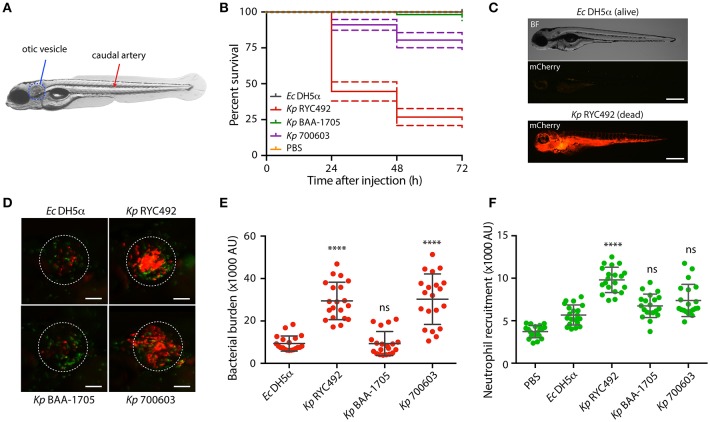
K. pneumoniae strains show different virulence behavior in the zebrafish larvae as revealed by survival curves and neutrophil recruitment. (A) Scheme of a 5-dpf zebrafish larva. Bacteria were injected in the dorsal caudal artery (red arrow) for establishing a rapid systemic infection, or in the otic vesicle (blue circle) for a localized infection. (B) Kaplan-Meier survival curves following injection of 3 dpf larvae with various strains of K. pneumoniae or with E. coli DH5α as a control. Larvae survival was monitored for 3 days after injection. The data are representative of three independent experiments, with a total of 57 larvae per bacterial strain. (C) Representative picture of a larva infected for 24 h with K. pneumoniae RYC492 strain, after acute bacteremia and death, and an unaffected larva injected with E. coli as a control. Bacteria expressing mCherry fluorescent protein is shown red. Scale bar, 500 μm. (D) Neutrophils attracted to the otic vesicle of Tg(BACmpo:gfp) zebrafish larvae injected with K. pneumoniae strains or E. coli DH5α after 24 h post-injection (hpi). Bacteria are red and neutrophils are green. The white dashed lines encircle the otic vesicle. Scale bar, 100 μm. (E) Bacterial burden in the otic vesicle of zebrafish larvae after 24 hpi. Measurements of red fluorescence from mCherry-labeled bacteria are plotted as arbitrary units (AU) for each K. pneumoniae strain or for E. coli DH5α. The data are representative of three replicates, with a total of 21 larvae per condition. (F) Neutrophils infiltrated in the otic vesicle of Tg(BACmpo:gfp) zebrafish larvae after 24 hpi. Measurements of green fluorescence from EGFP-labeled neutrophils are plotted as arbitrary units (AU) for larvae injected with K. pneumoniae strains, E. coli DH5α, or PBS. The data are representative of three independent experiments, with a total of 21 larvae per bacterial strain. Error bars represent the standard deviation among the replicates. Statistical differences compared to E. coli DH5α were assessed using a Kruskal-Wallis analysis followed by Dunn's multiple comparisons test. ****p < 0.0001.